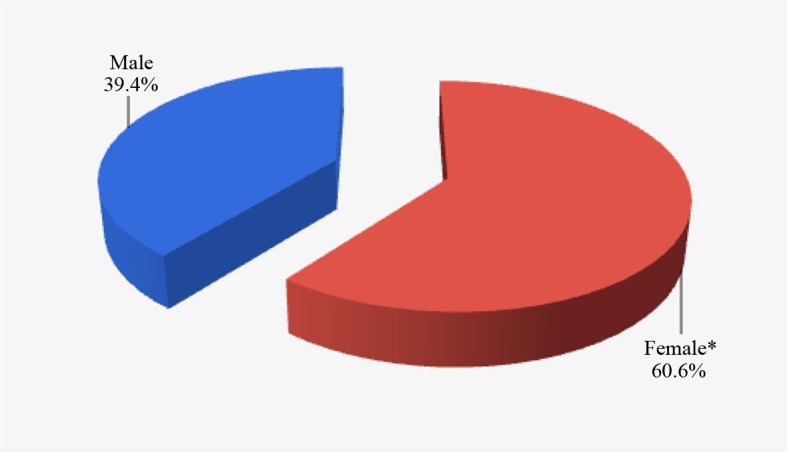
Distribution of sample by sex. *p < 0.05.